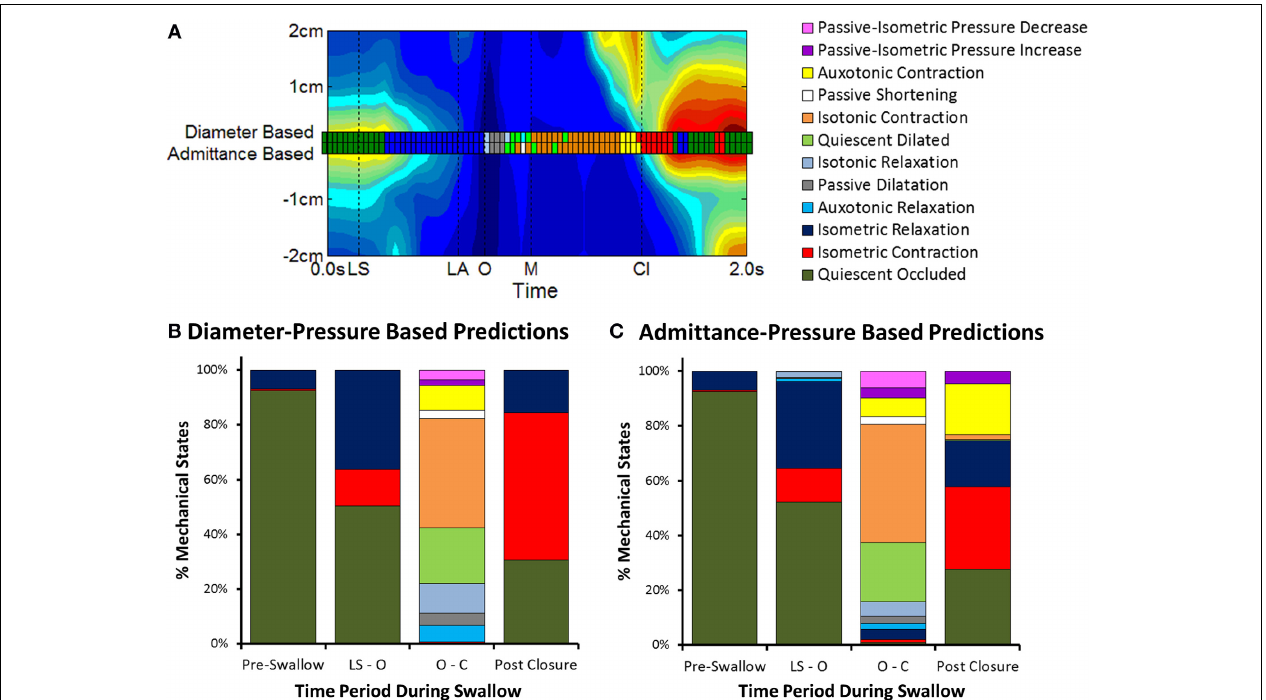
FIGURE 8 | Changes in mechanical states over time. (A) Comparison of UES mechanical states determined over time for an individual swallow (example swallow in Figure 7A ). A separate series of mechanical states are shown superimposed on a spatio-temporal plot of UES relaxation (colored squares) based on the relationships of diameter-pressure and admittance-pressure. Vertical black lines indicate timings of important radiological features; onset of laryngeal superior movement (LS), onset of